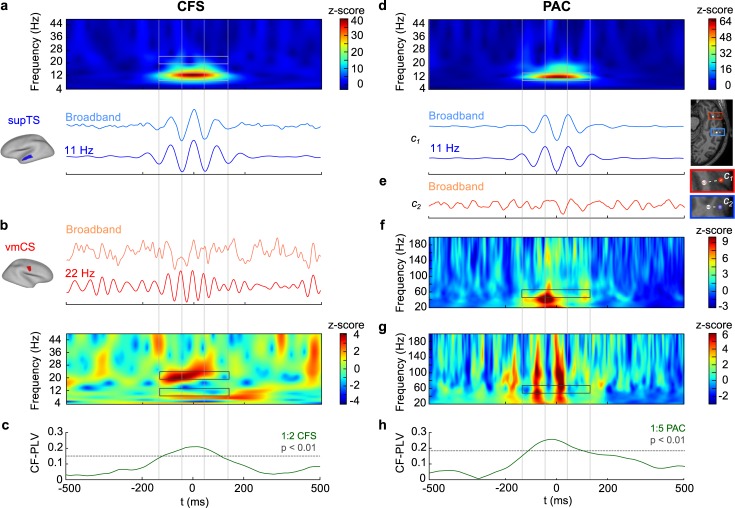
Genuine interareal CFS and PAC at the single-subject level.(a) Averaged broadband time series and α-band (11 Hz)–filtered LF time series time-locked to the α peaks in the left supTS for a representative MEG subject. TFR of the broadband average reveals α oscillations (highlighted by lower gray box) but an absence of β oscillations (in area of upper gray box) and thus the absence of both nonsinusoidal filter artifacts and genuine local 1:2 CFS. (b) Averaged broadband-filtered and β-band (22 Hz)–filtered HF time series for right vmCS time-locked to the α LF peaks identified in supTS. TFR of the broadband average reveals β oscillations but an absence of α oscillations. Thus, vmCS shows no filter artifacts, local CFS, or interareal α or β CFS (highlighted by gray boxes). (c) PLV time series (green line) for 1:2 α:β CFS for the LF and HF time series averaged over α-peak time-locked segments. Dotted gray line shows the PLV value above which CFS is significant at p < 0.01. (d) Averaged broadband-filtered and α-band (11 Hz)–filtered LF time series time-locked to the α troughs in an electrode contact c1 located in the mTG in a representative SEEG subject. The electrode location is marked by the red circle on the brain, and the closest white matter contact (used as reference) by the white circle next to it. TFR of the averaged broadband time series reveals α oscillations (highlighted by gray box) and an absence of higher-frequency components, suggesting the absence of systematic nonsinusoidal filter artifacts that would show up as local CFS here. (e) Averaged broadband time series in an electrode contact c2 in iTS that is time-locked to the α troughs in contact c1 reveals no clear α oscillations, showing an absence of α PS between c1 and c2. The location of electrode contact c2 is marked by the blue circle on the brain, and the closest white matter contact (reference) by the white circle next to it. (f) TFR of oscillation amplitudes in c1 time-locked to α peaks shows little modulation of γ amplitudes by α phase at frequencies above 40 Hz. (g) TFR of oscillation amplitudes in c2 show comodulation of γ amplitudes in c2 and α cycles (i.e., α phase) in c1. The frequency region at around 55 Hz, at which the HF of the 1:5 PAC should be seen, is marked with gray boxes. (h) PLV time series (green line) for 1:5 PAC between LF time series in c1 and LF-filtered amplitude envelope of 55 Hz NB in c2. Dotted gray line shows the PLV value above which PAC is significant at p < 0.01. Plot data for a–h are available online at https://datadryad.org/stash/dataset/doi:10.5061/dryad.0k86k80. CFS, cross-frequency PS; HF, high frequency; iTS, inferior temporal sulcus; LF, low frequency; MEG, magnetoencephalography; mTG, middle temporal gyrus; NB, narrowband; PAC, phase–amplitude coupling; PLV, phase-locking value; PS, phase synchrony; SEEG, stereoelectroencephalography; supTS, superior temporal sulcus; TFR, time frequency representation; vmCS, ventromedial central sulcus.